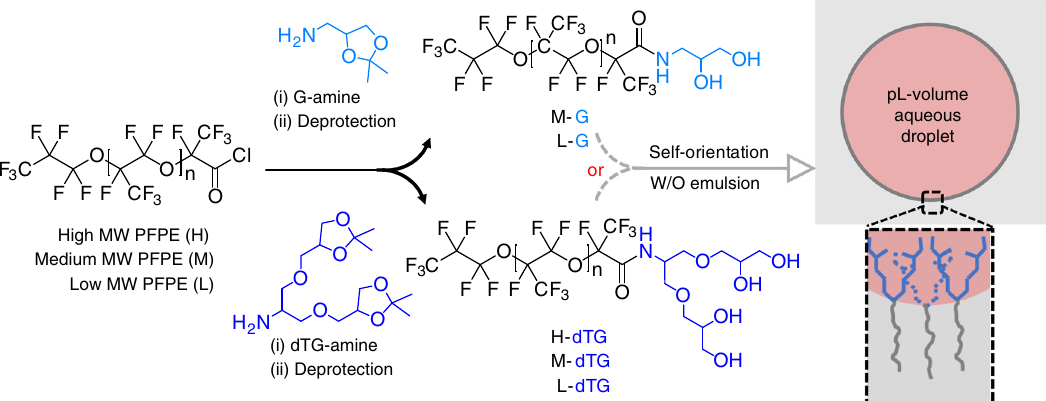
Fig. 1 Synthesis of fl uorosurfactants with dendritic glycerol head groups. PFPE tails of two different fl uoro-chain lengths (M, L) were conjugated to the mono-glycerol (G) polar head (upper drawing, light blue) to create surfactants M-G and L-G; PFPE tails of three different molecular weights (H, M, L) were conjugated to dendritic tri-glycerol (dTG) polar head to create surfactants H-dTG, M-dTG, and L-dTG (lower drawing, blue). These surfactants orient at the interface (deep gray) of water (light red) and fl uorinated oil (gray) to stabilize picolitre-volume (pL) water-in-oil (W/O) emulsion droplets, as depicted